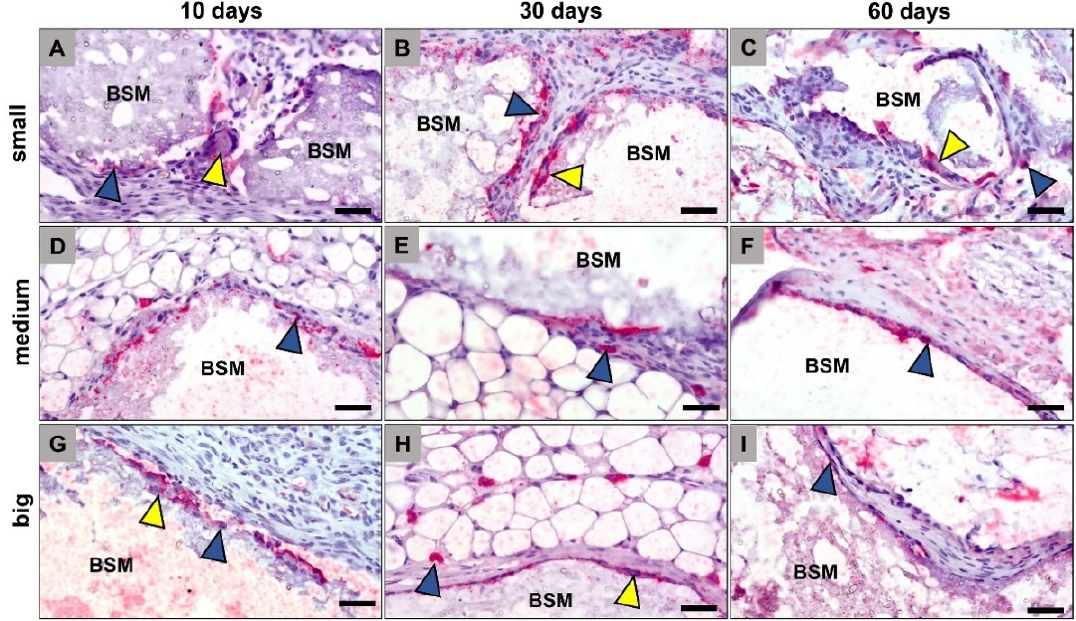
Figure 3. Exemplary histological images of pro-inflammatory (CD11c-positive) macrophages (blue arrowheads) and multinucleated giant cells (yellow arrowheads) within the implant beds of the differently sized bone substitute materials (BSM), i.e., the small BSM granules ( A – C ), the medium-sized BSM granules ( D – F ), and the big BSM granules ( G – I ). CT = connective tissue (CD11c-immunostainings, 400× magnifications, scalebars = 50 µm).